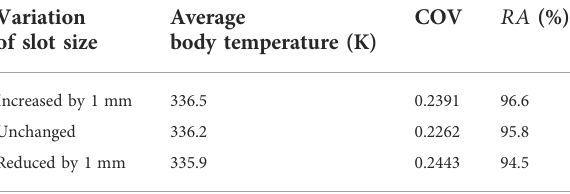
TABLE 6 Effect of variation of the slot length on the heating effect.